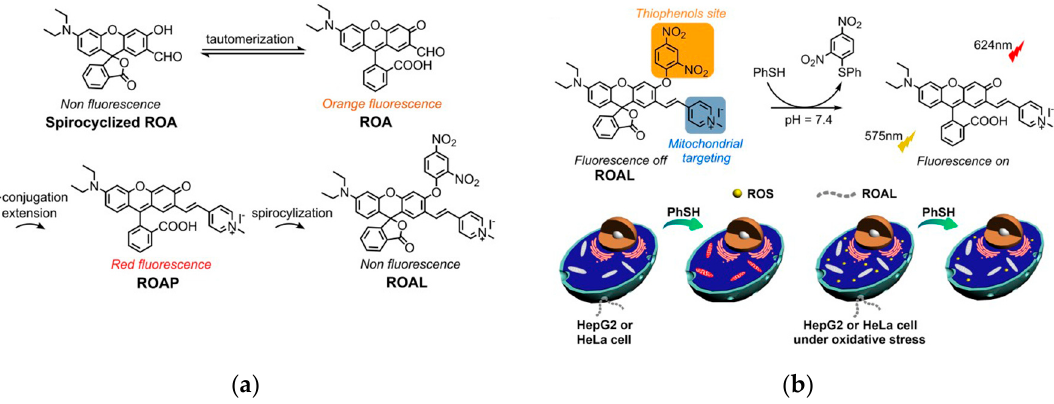
Figure 16. Detection of mitochondrial thiophenols: ( a ) Structures of the probes ROA , ROAP and ROAL ; ( b ) The proposed sensing mechanism of ROAL towards thiophenols. Adapted with permission from [226].